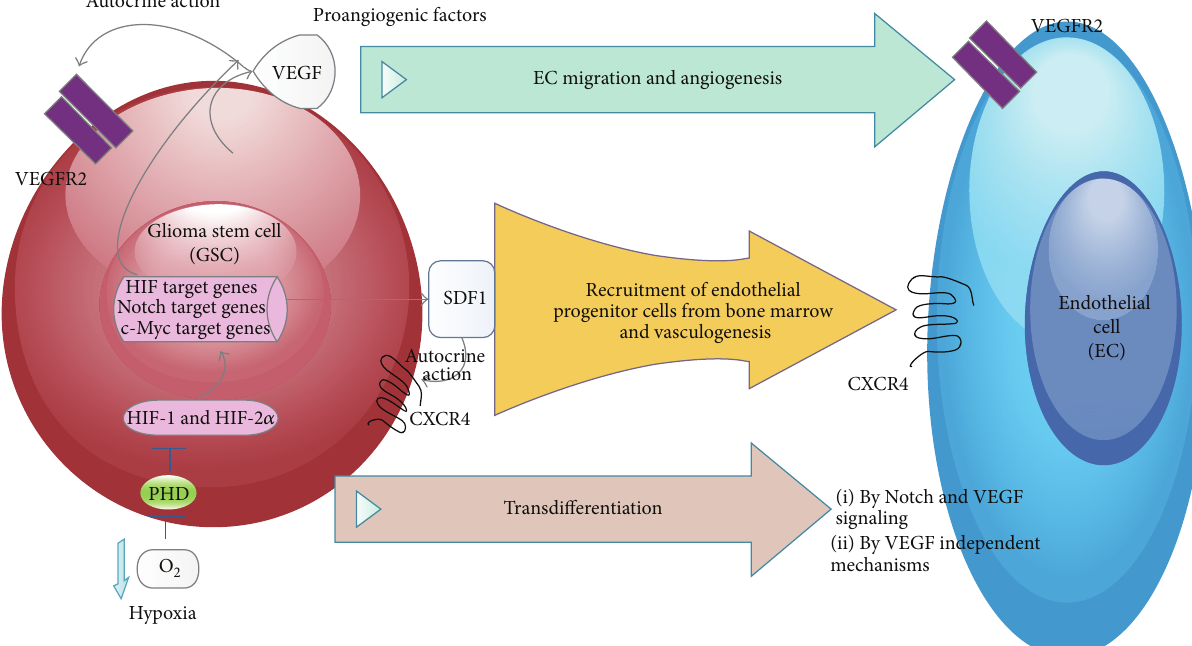
Figure 2: Effects of hypoxia on GSCs and effects of GSCs on the endothelial cells. GSCs produce proangiogenic growth factors VEGF and HDGF that stimulate EC migration and angiogenesis; SDF-1 stimulates recruitment of endothelial progenitor cells from bone marrow and vasculogenesis; GSCs can transdifferentiate under hypoxic condition into